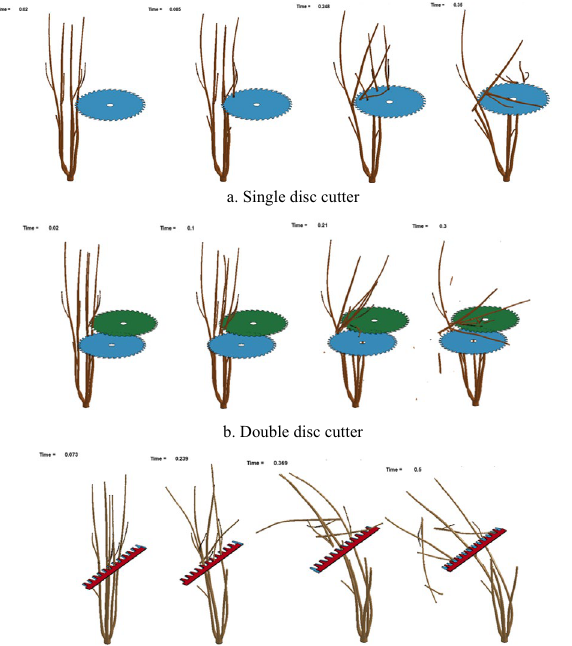
Figure 2. The process of cutting rose stem.